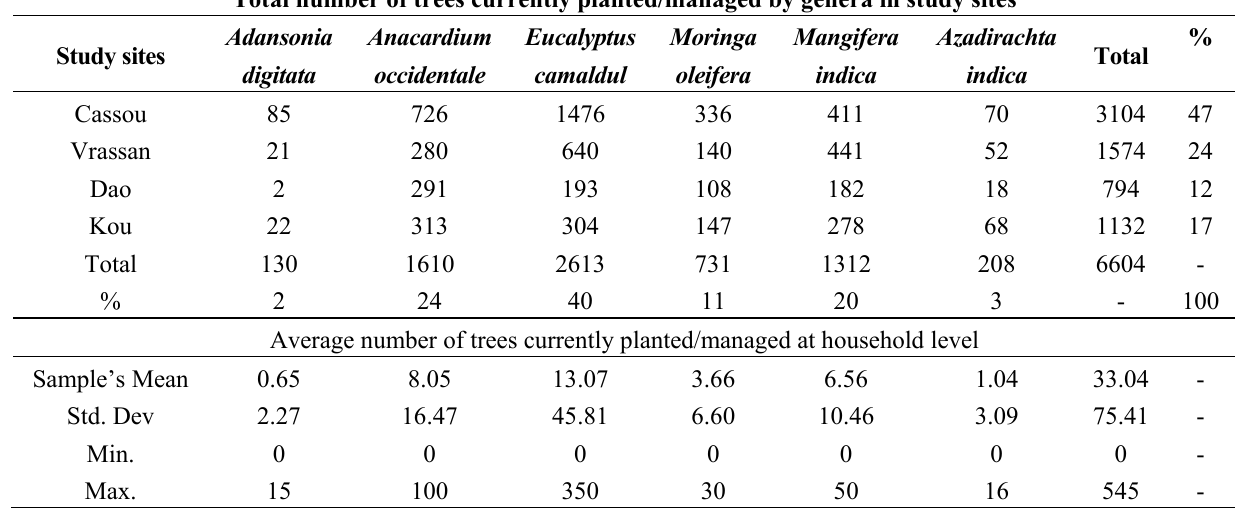
Table 1. Number of trees currently planted or managed.